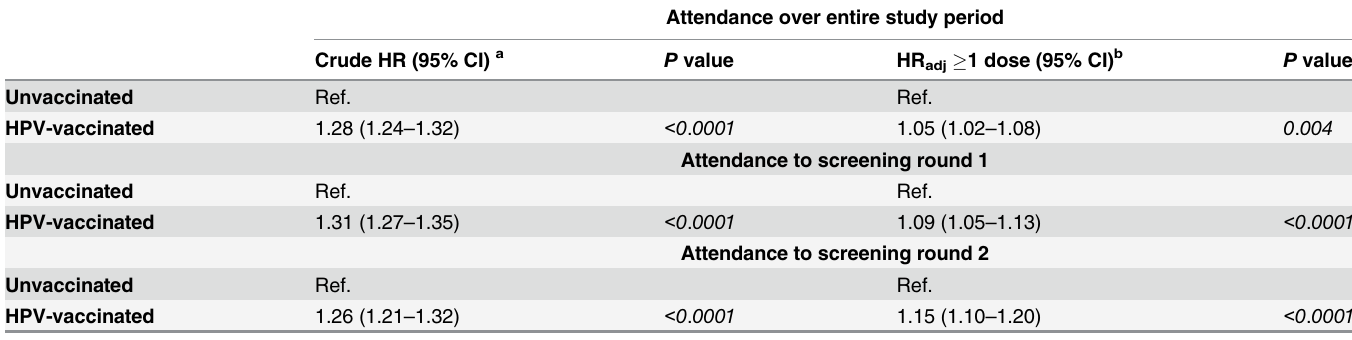
Table 2. Crude and adjusted hazard ratios from the main effects model of screening attendance in HPV-vaccinated women compared to unvacci- nated women during the entire study period, and by round 1 and 2 during